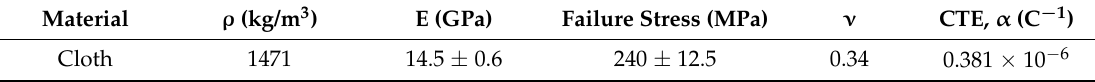
Table 9. Tensile and thermal expansion properties for the polyester veil cloth/epoxy.